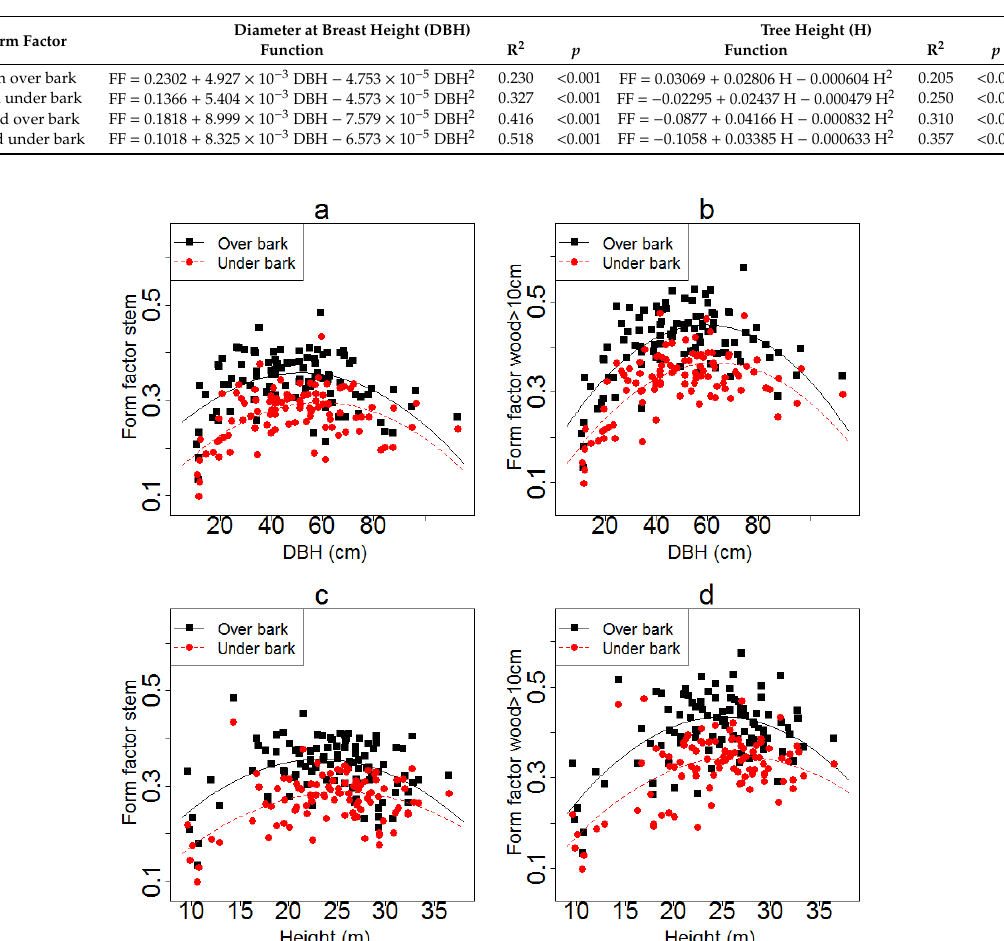
Figure 3. Over bark and under bark FF (form factor) of Shorea robusta, ( a ) FF of stem as a function of DBH, ( b ) FF of wood >10cm diameter as a function of DBH ( c ) FF of stem as a function of height, ( d ) FF of wood >10cm diameter as a function of height.